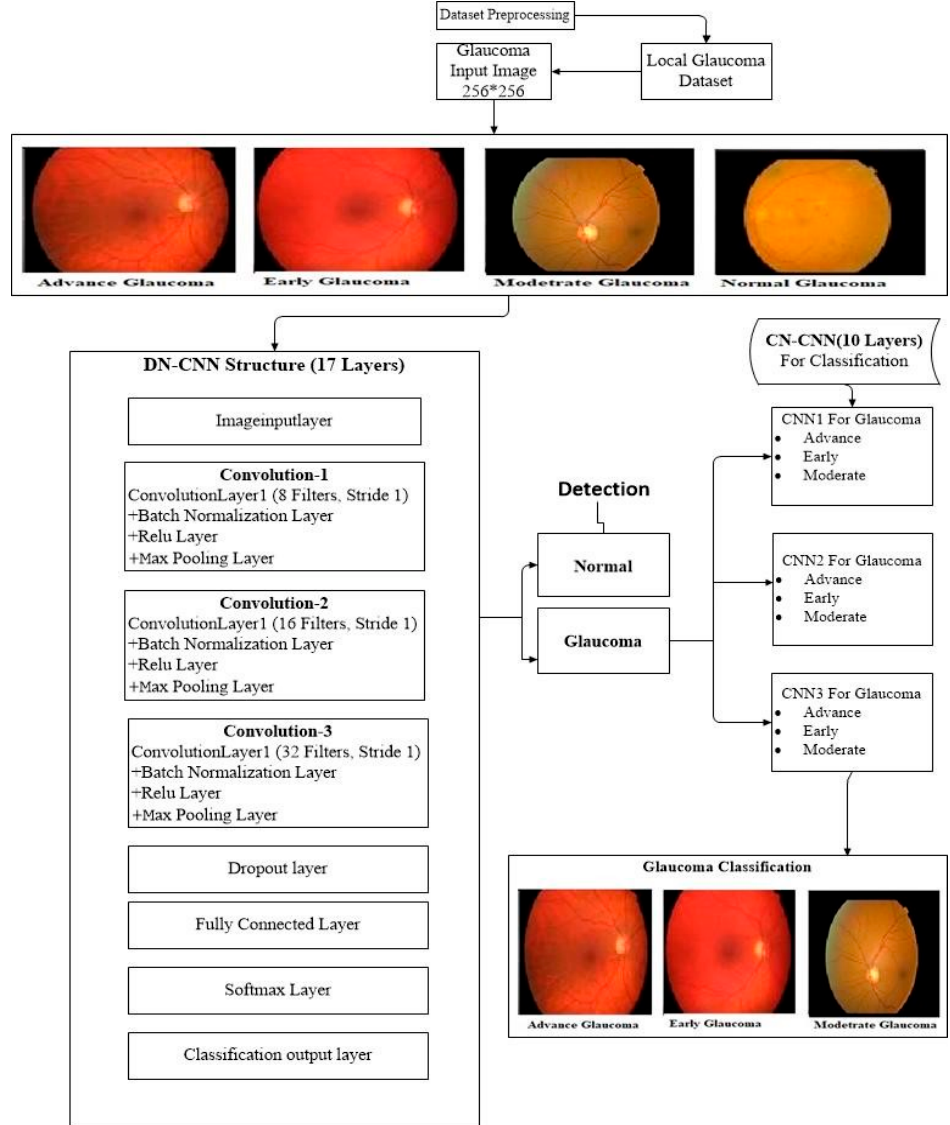
Figure 2. The Representation of Working Process of the (ML-DCNN). Algorithm 1 Proposed Glaucoma detection and classification framework.